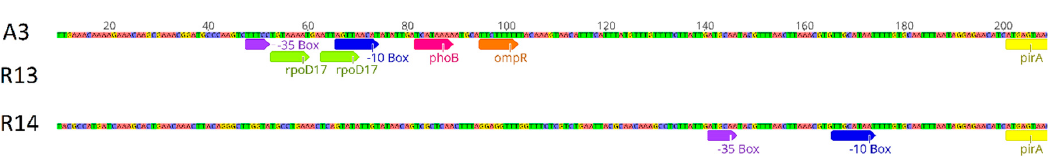
Figure 7. Promoter regions of A3, R13 and R14 and transcriptional factor binding sites; the descriptions of each site and their location are shown. Using BPROM in V. parahaemolyticus strain A3, the transcriptional factors, − 35 box, rpoD17 (transcriptional binding site), − 10 box, phoB (transcriptional regulatory protein PhoB site) and ompR (transcriptional regulatory protein OmpR site) were identified. In strain R13, this entire genomic region is deleted, and in the R14 strain, − 35 box and − 10 box were identified.